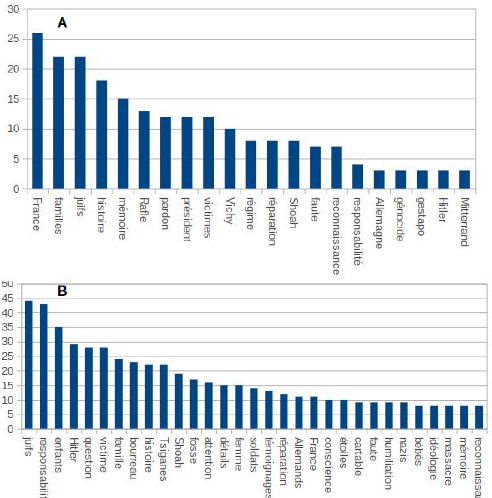
Figure 9. Graphs of the occurrences of the most used words in the participants' speech: A. during the class focus group.